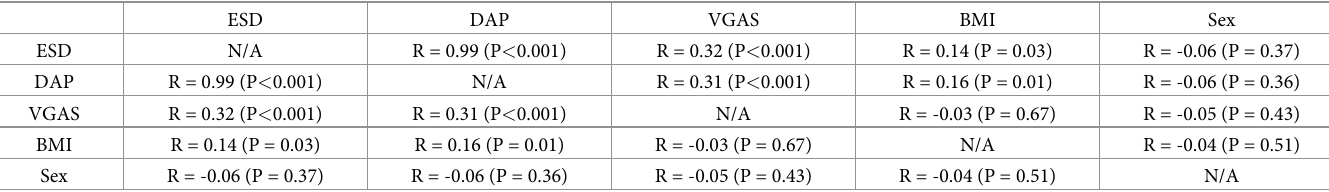
Table 4. Analysis of the correlations between ESD, DAP, VGAS, BMI, and sex in the three groups (n =